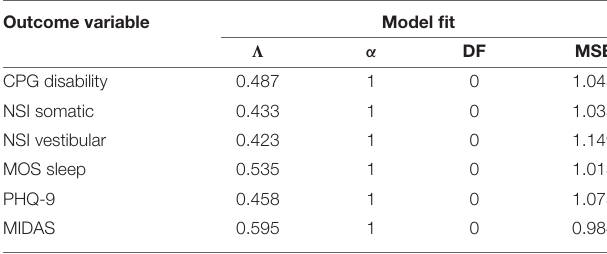
TABLE 7 | Model fits for outcomes not predicted by EEG